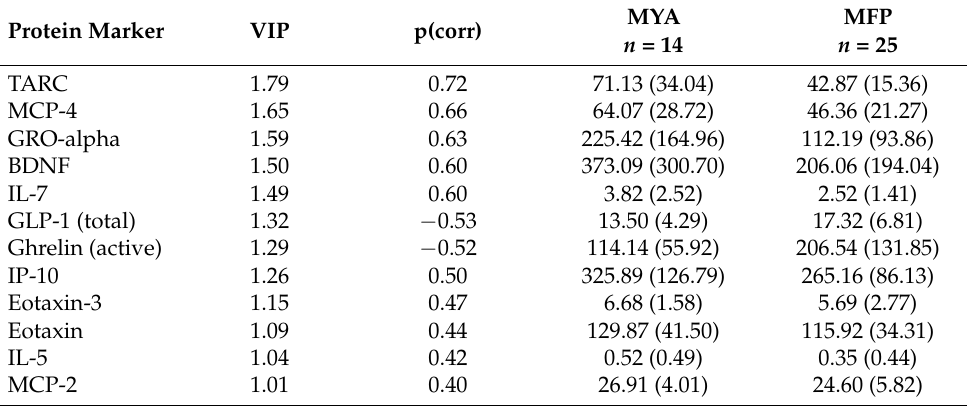
Table 4. OPLS-DA model of patients with temporomandibular disorders myalgia (MYA) and my- ofascial pain (MFP). Twelve proteins discriminated between groups and had a VIP-value > 1.0. Ten of the proteins showed a positive intercorrelation (p(corr)) in MYA and were upregulated compared to MFP. Two proteins (ghrelin (active) and GLP-1 (total)) were downregulated in MYA, i.e., had a negative p(corr). Protein markers are sorted according to VIP-value. The two columns to the right show the protein concentration (pg/mL).